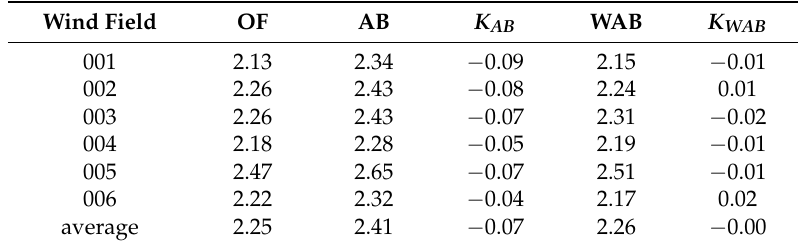
Table 5. Dispersion error (m/s) and change rate K (%) of three outputs of ensemble